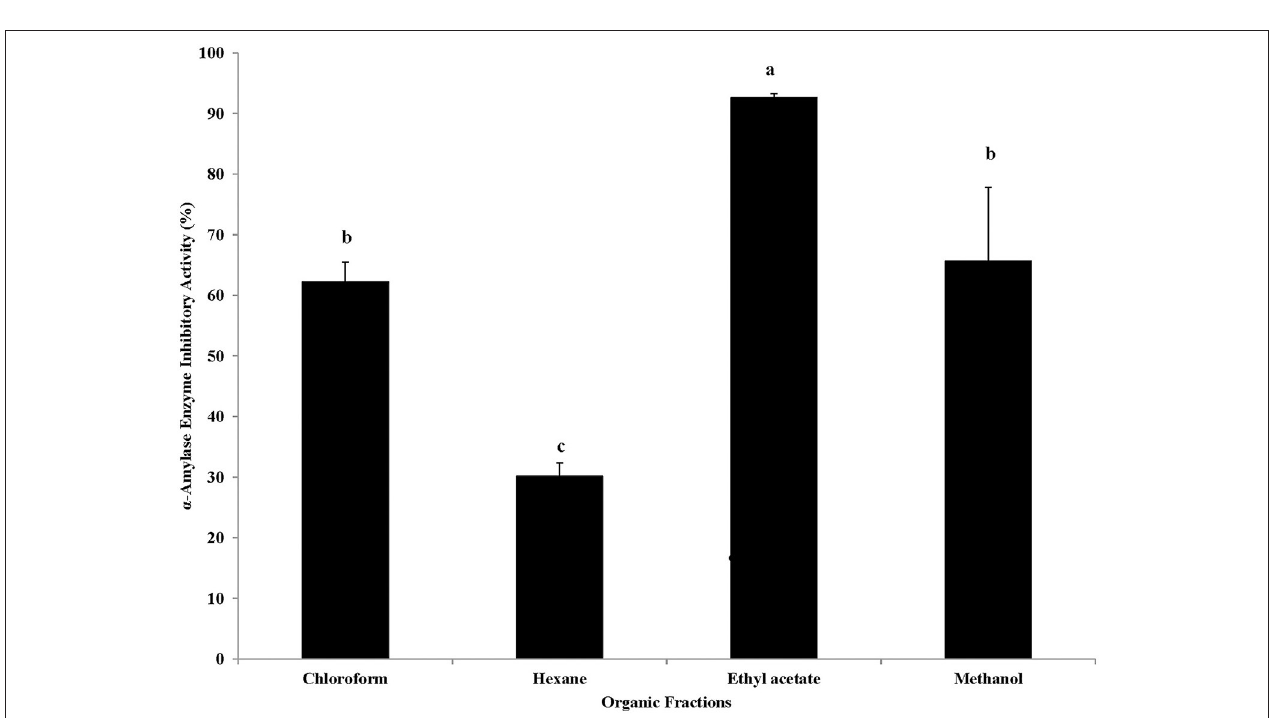
FIGURE 5 | α -Amylase enzyme inhibitory activity (% inhibition) of undiluted samples of four organic solvent extracted fractions of red dried calyces of Roselle. Different lower-case letters represent statistically significant differences in α -amylase enzyme inhibitory activity between different organic solvent extracted fractions at 95% confidence level (Tukey’s